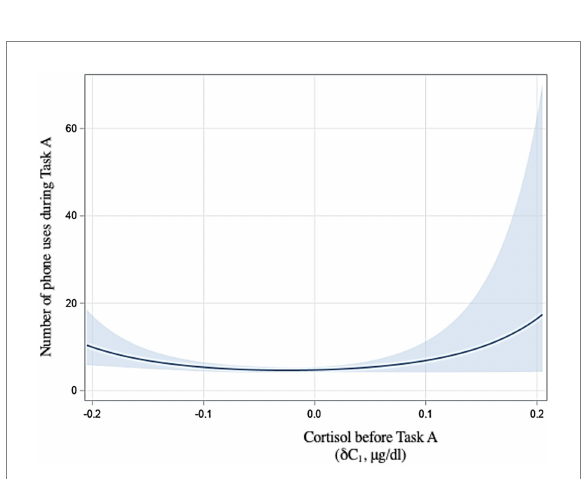
FIGURE 3 Relationship between physiological stress before Task A and number of phone uses with 95% confidence